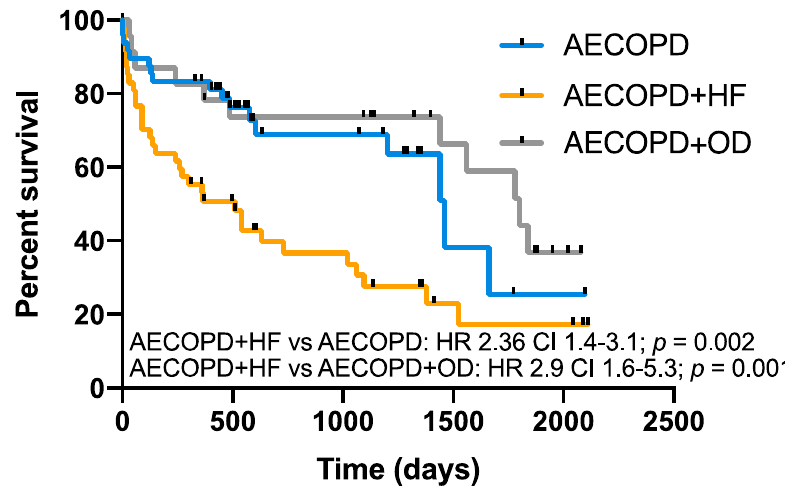
Figure 3. Long-term survival according to RW diagnosis. Kaplan – Meier plots showing survival in COPD patients with AECOPD, AECOPD and HF and AECOPD and OD over the follow-up period (overall comparison p = 0.001). AECOPD and HF had lower survival compared to AECOPD ( p = 0.002) and AECOPD + OD ( p = 0.001).